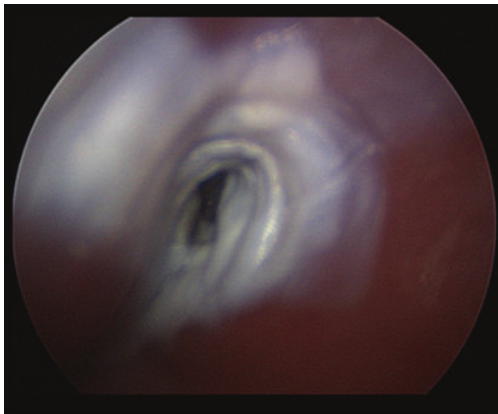
Figure 3: Right pyriform sinus fistulous tract cannulated with straight laryngeal probe (arrow).